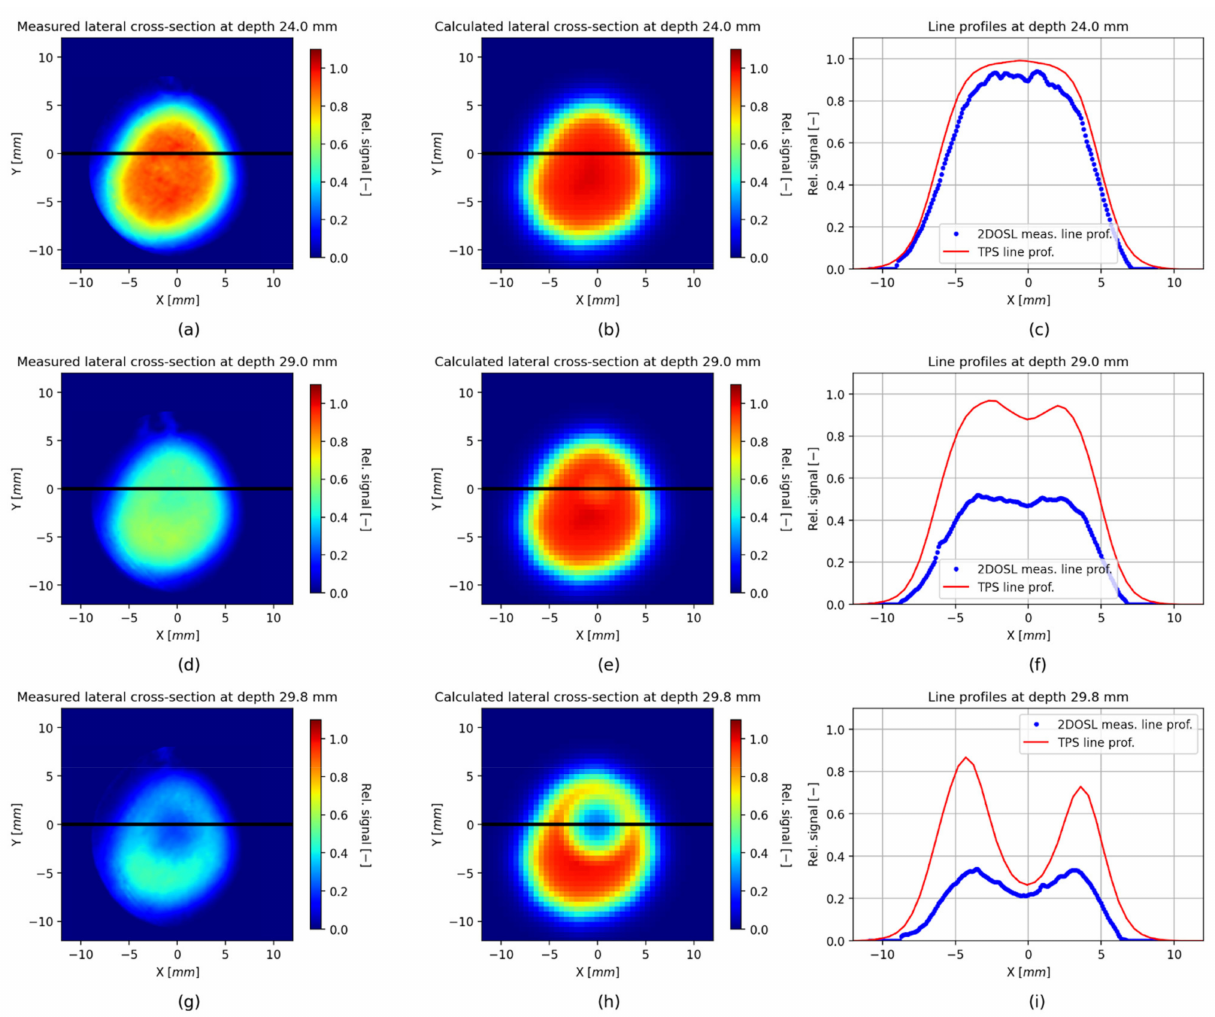
Figure 12. Lateral cross-sections extracted from the 3D relative dose image measured with the stack of 2D LMP foils ( a , d , g ) and from 3D relative dose image calculated by the TPS ( b , e , h ) at depths of 24 mm (middle of the SOBP), 29 mm (range of the SOBP at 90% of the distal fall-off) and 29.8 mm (10% of the distal fall-off), respectively; ( c , f , i ) Comparisons of line profiles along the X axis for corresponding depths. The depths are indicated with black dashed lines in Figure 11 (panel a and